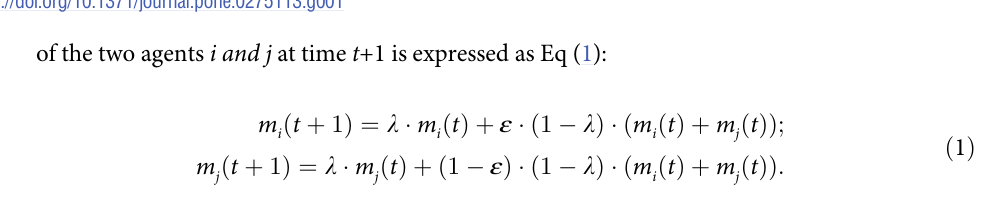
Fig 1. Exchange models. (A) Before exchange, (B) R model (random exchange), (C) L model (loan interest), and (D) J model (joint venture). λ is savings rate, ε is division probability, ρ is interest rate, and δ is profit/loss rate.